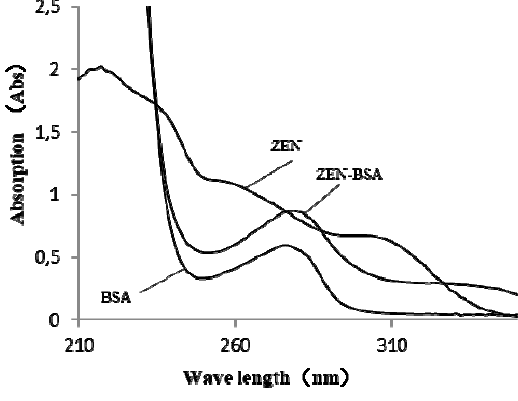
Fig. 4. UV spectra of ZEN-BSA synthesized